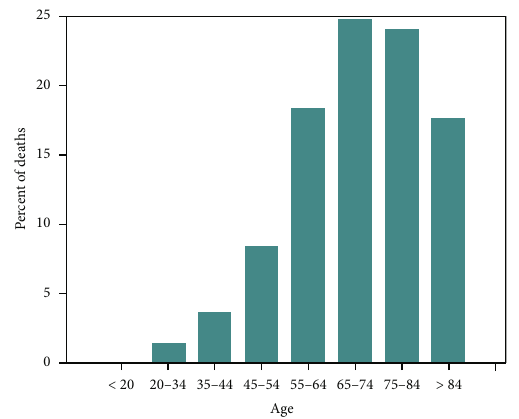
Figure 5: Percentage of deaths for melanoma skin cancer w.r.t. age structure groups in United State from 2015 to 2019 (Source: [3]).